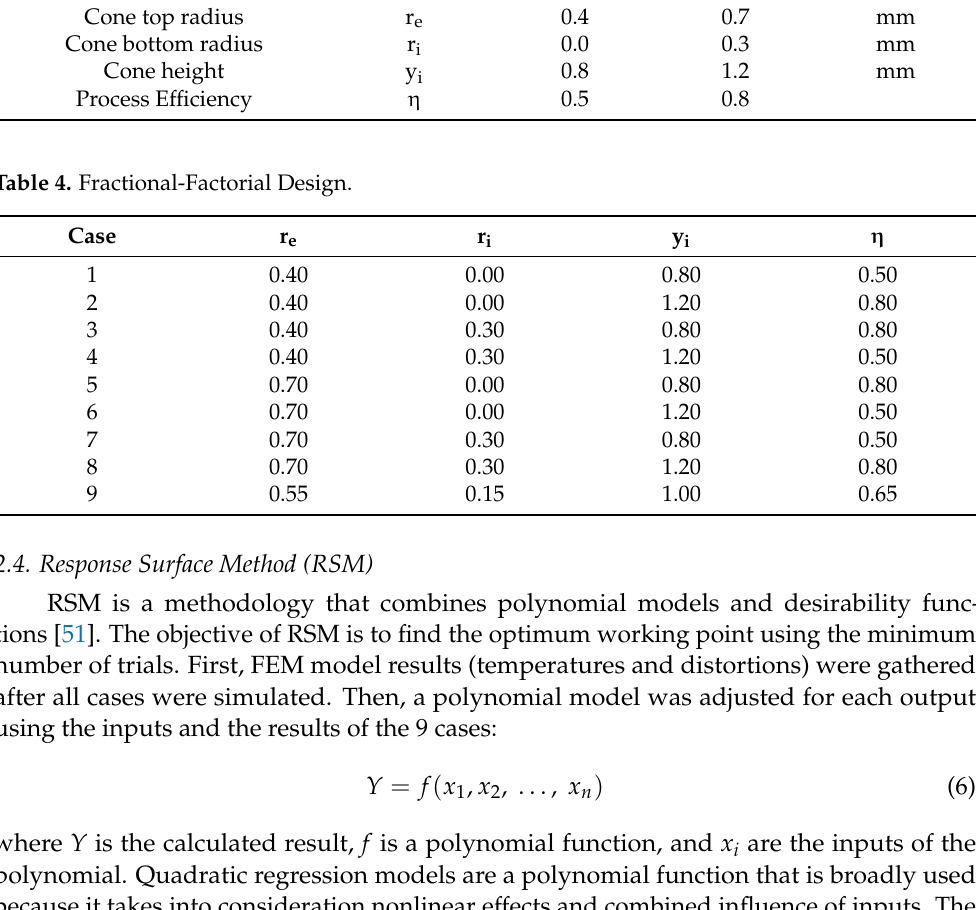
Table 3. DoE parameters: factors, ranges, and units. Factor